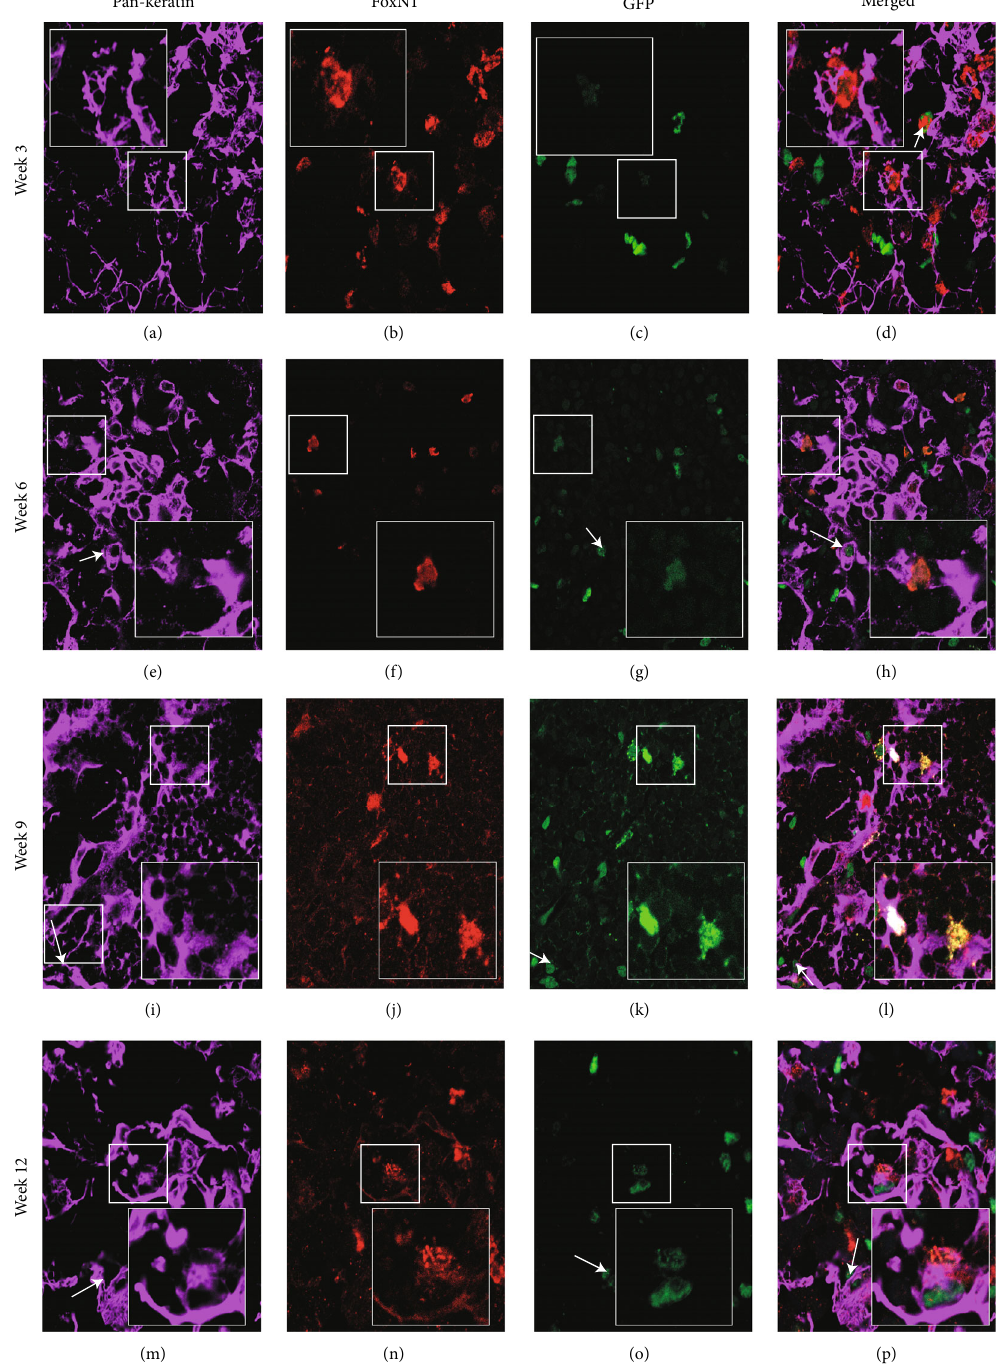
Figure 5: A peripheral population can migrate into the thymus and contribute to PanK- and FoxN1-expressing thymic epithelial cells. C57BL6 fetal thymi were transplanted under the kidney capsule of actin H2BGFP mice and analyzed for the presence of GFP-expressing peripheral cells 3-12 weeks after transplant using IHC. (a – d) Week 3 transplanted thymic tissue sections showing expression of PanK (a), GFP+ peripheral cells (b), FoxN1 (c), and merged image (d). (e – h) Week 6 transplanted thymic tissue section showing expression of PanK (e), GFP+ peripheral cells (f), FoxN1 (g), and merged image (h). (i – l) Week 9 transplanted thymic tissue section showing expression of PanK (i), GFP+ peripheral cells (j), FoxN1 (k), and merged image (l). (m – p) Week 12 transplanted thymic tissue section showing expression of PanK (m), GFP+ peripheral cells (n), FoxN1 (o), and merged image (p). GFP-, PanK-, and FoxN1-expressing cells of interest are enlarged in the insets to show colocalization of both proteins and represent the cells shown in the white boxes. PanK+ FoxN1+ GFP+ cells and PanK+ FoxN1- GFP+ cells at all time points are indicated by white and red arrows, respectively. The results presented are representative of the three to fi ve replicates of each experiment that were